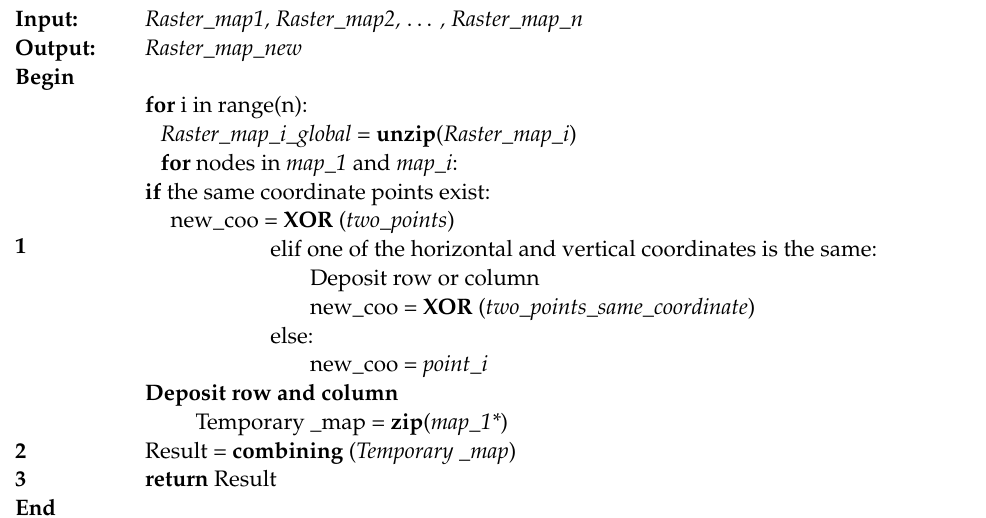
Algorithm 3 The Map Splicing and Updating